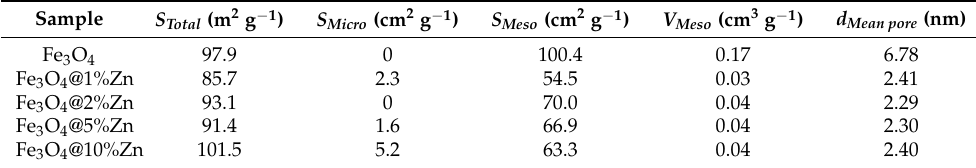
Table 2. Surface areas and pore volumes of five samples.